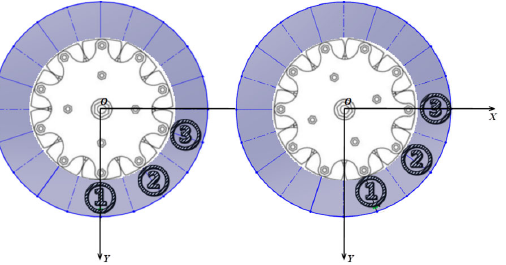
Figure 3. Obstacle surmounting posture of transformable wheel ( Left : standard status; Right : limit state; segment unit number: ① , ② and ③ , from ground by anti ‐ clockwise).